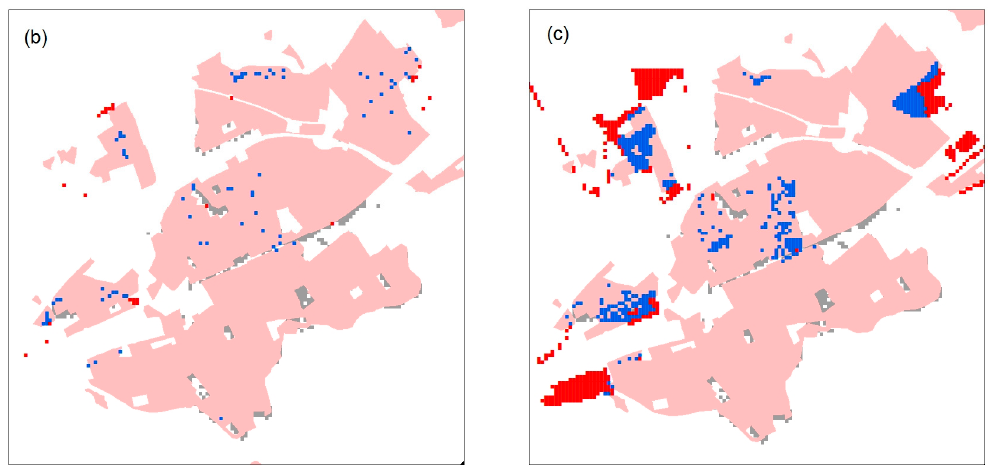
Figure 12. Simulated and observed built-up area growth in a zoomed area (municipality: Alcalá de Henares): Comparison between the simulated residential buildings for the three scenarios (pixels)—( a ) sustainable, ( b ) crisis, and ( c ) speculative—and the urban land cartography (surface) from the SIOSE database (2011) [59].